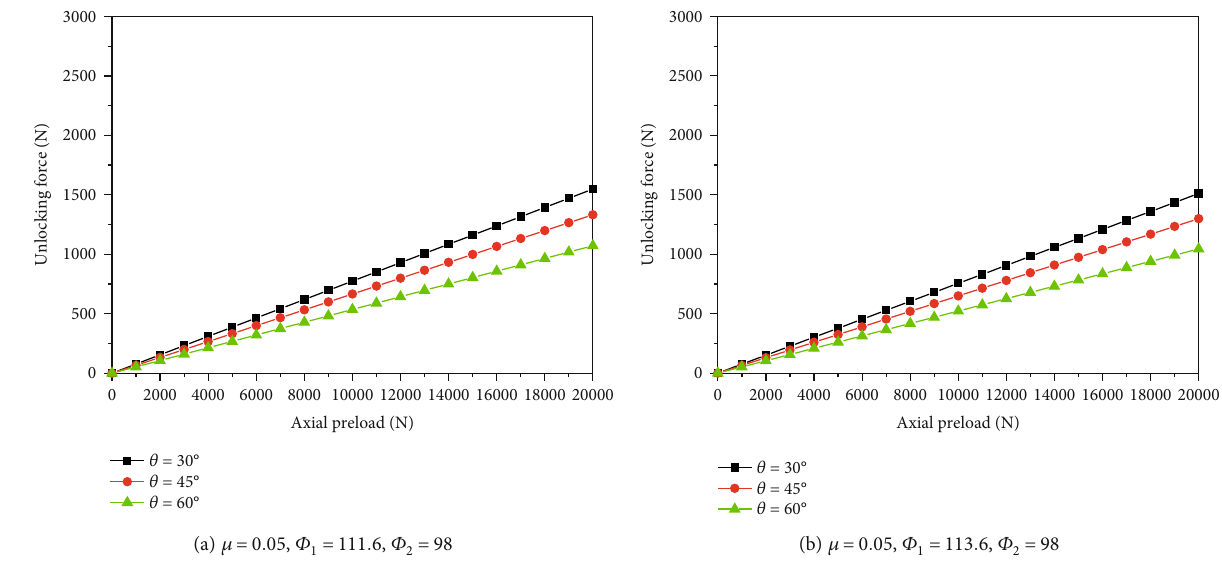
Figure 25: In fl uence of fi ngertip angle θ on unlocking force of the fi nger lock. Table 7: Wear thickness corresponding to di ff erent Φ 1 .